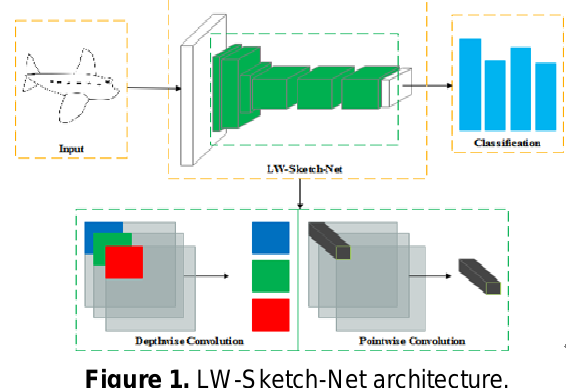
Figure 1. LW-Sketch-Net architecture.